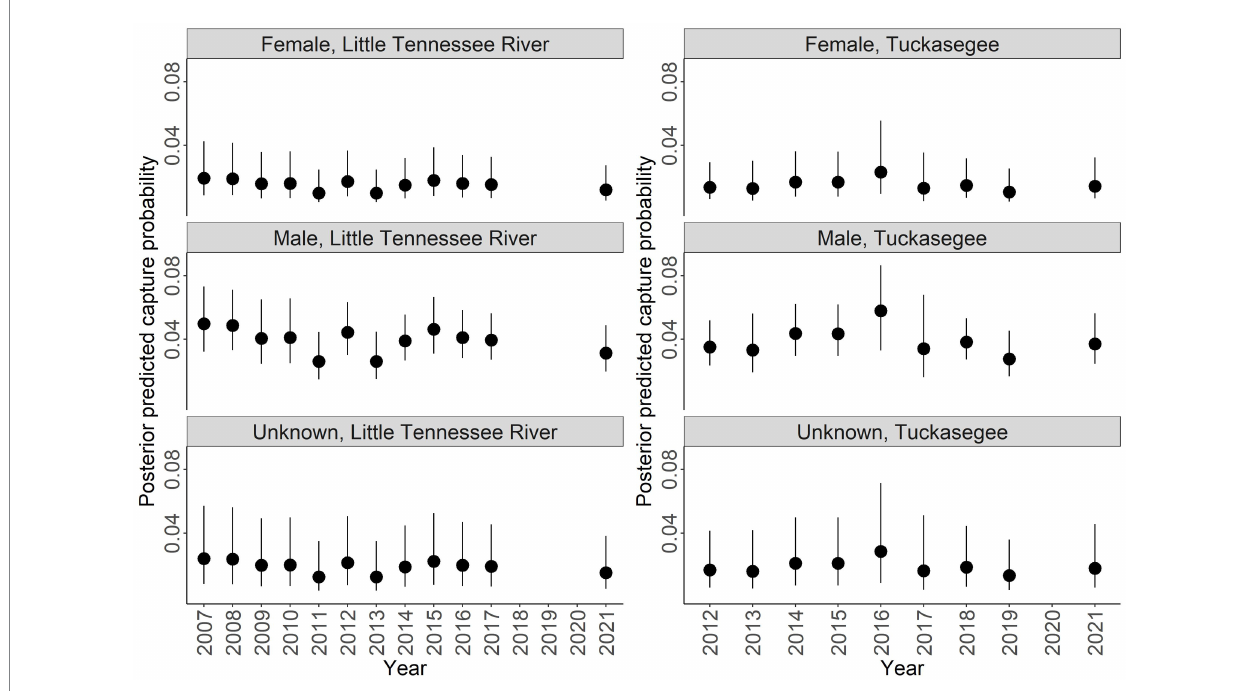
FIGURE 6 Posterior predicted capture probability of Sicklefin Redhorse Moxostoma sp. for the Little Tennessee River (left) and Tuckasegee (right) for female, male, and unknown sex. Dark solid line represents the median and shaded area with dashed line represents the bounds of the 95% credible intervals.